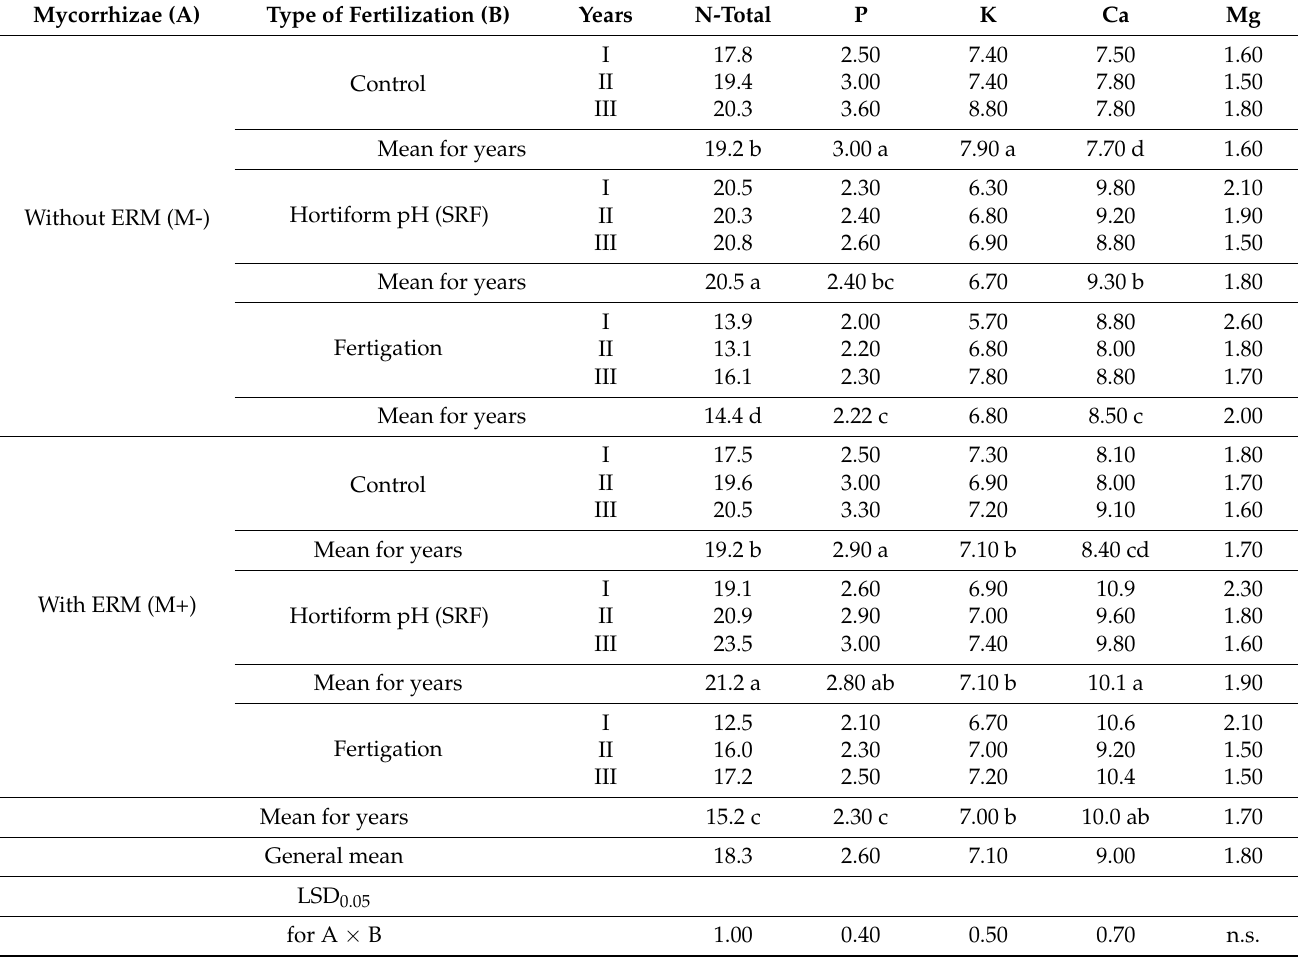
Table 1. Effect of type of fertilization and mycorrhization on content of N-total, P, K, Ca and Mg (g · kg − 1 d.m.) in leaves of azalea cv. ‘Anneke’. Mycorrhizae (A)